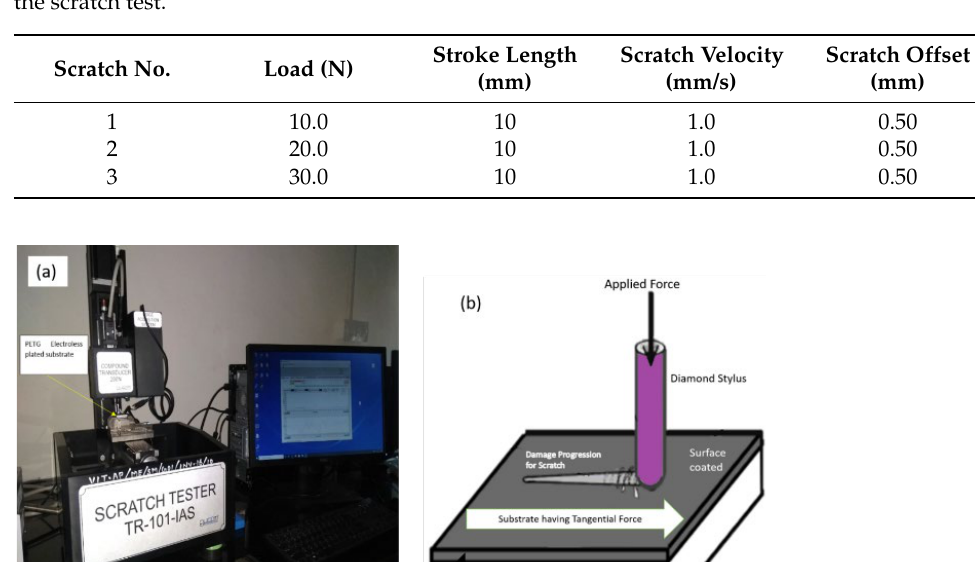
Table 1. Scratch number, load, stroke length, scratch velocity, and scratch offset tabulated values for the scratch test.